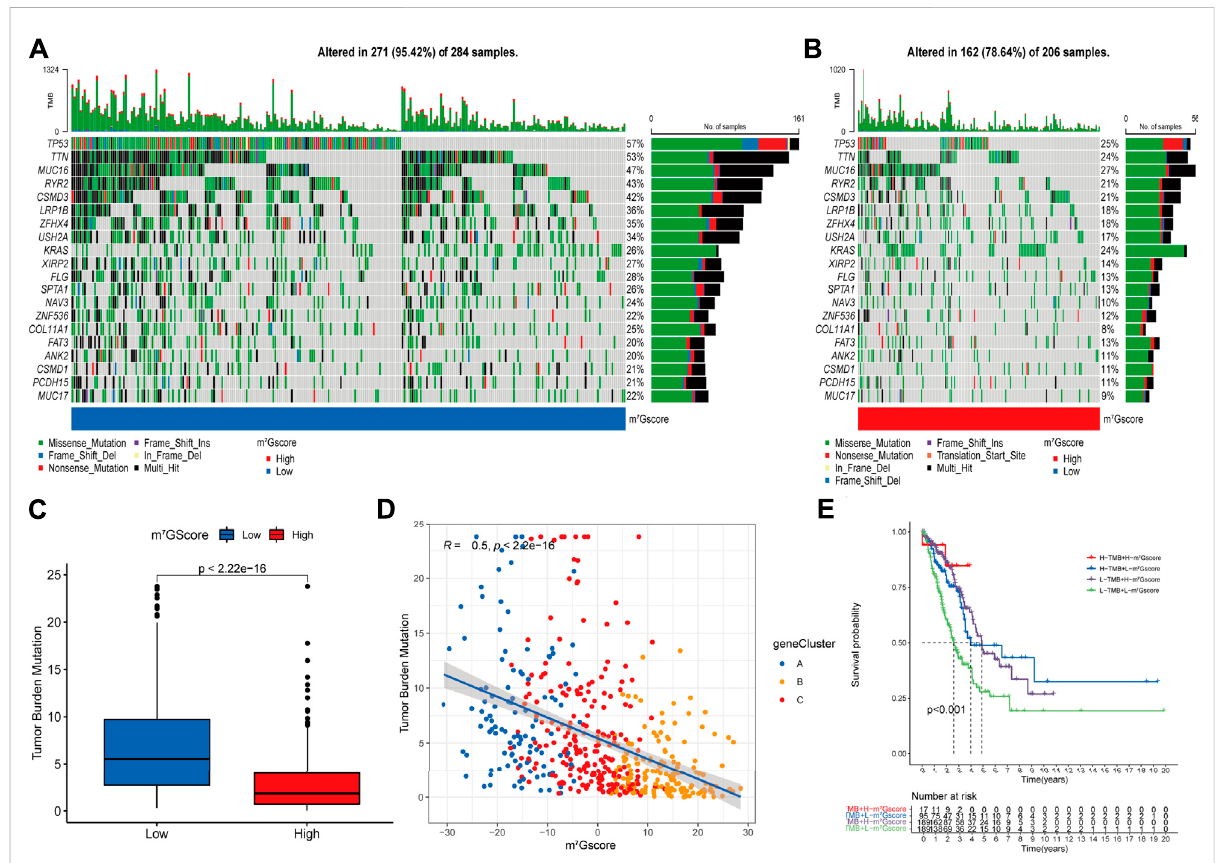
FIGURE 7 The correlation of m 7 Gscore and the tumor somatic mutation. (A,B) The waterfall plot of tumor somatic mutation in LUAD patients with low m 7 Gscore (A) and high m 7 Gscore (B) , each column represents individual patients. The top barplot depicts tumor mutation burden (TMB) and mutation frequency in each gene is given on the right. The right barplot depicts the proportion of each variant type. The stacked barplot below depicts fraction of conversions in each sample. (C,D) The relationship between the m 7 Gscore and TMB. (E) The Kaplan – Meier curves of the OS of subgroup patients strati fi ed by the m 7 Gscore and